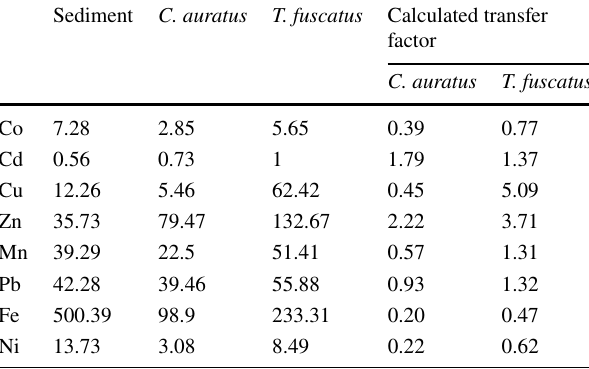
Table 7 Calculated transfer factor